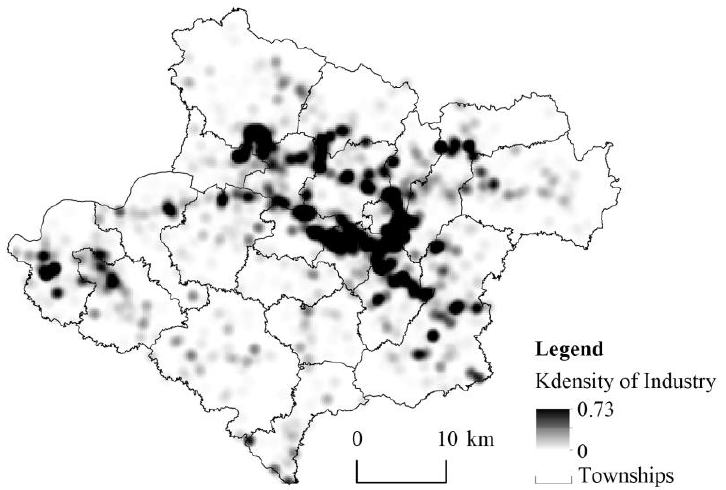
Figure 6. Kernel density of industry in Xintai.